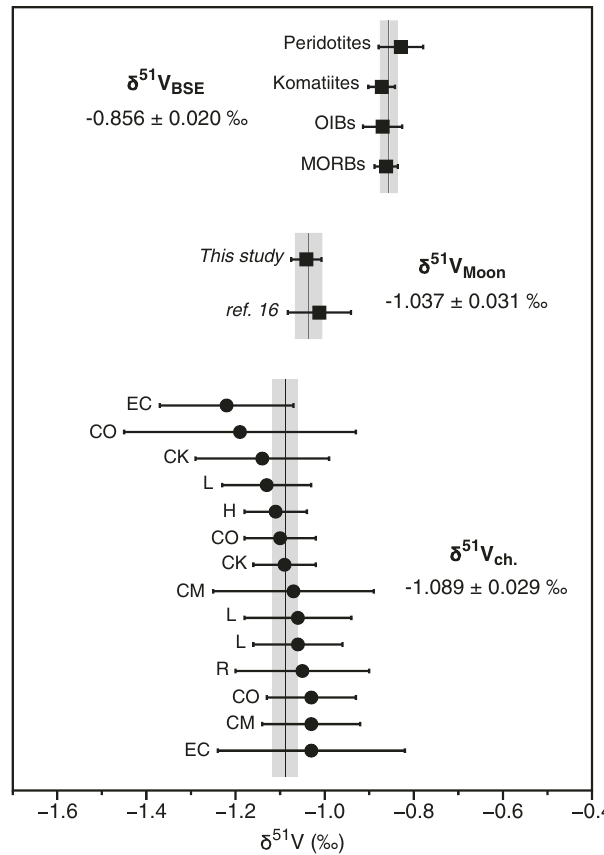
Fig. 2 Average vanadium isotope compositions for primitive mantle derived terrestrial samples, GCR-corrected lunar samples and GCR- corrected chondrite samples. Error bars are 2SE for terrestrial samples and the two studies of lunar samples (square markers; Supplementary Note 2). Chondrite data are individual samples with 2 SD error bars (circle markers) 14 . Individual data for terrestrial samples previously compiled 14 . Lunar sample data can be found in Supplementary Table 1. Error-weighted averages and 2SE for each reservoir are shown as vertical gray bars behind each sample group (Supplementary Note 2 and ref. 14